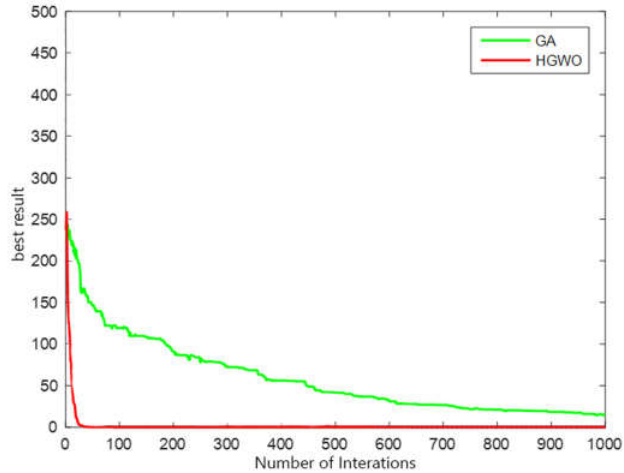
Figure 9. Sphere function—objective function value vs. iteration number.